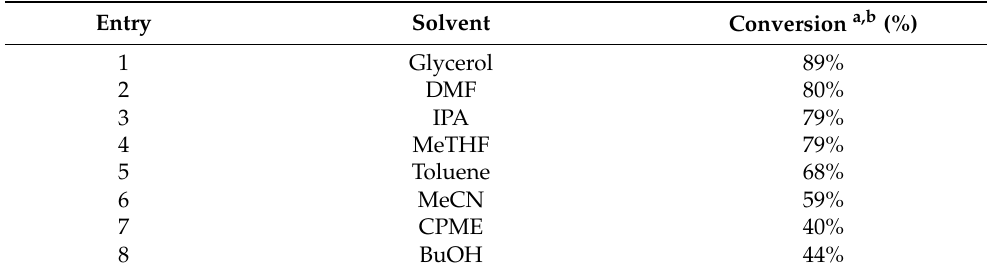
Table 5. a Reaction conditions: 0.250 mmol of 1a, 0.275 mmol of 2a, 0.300 mmol K 2 CO 3 , 0.1 mol%